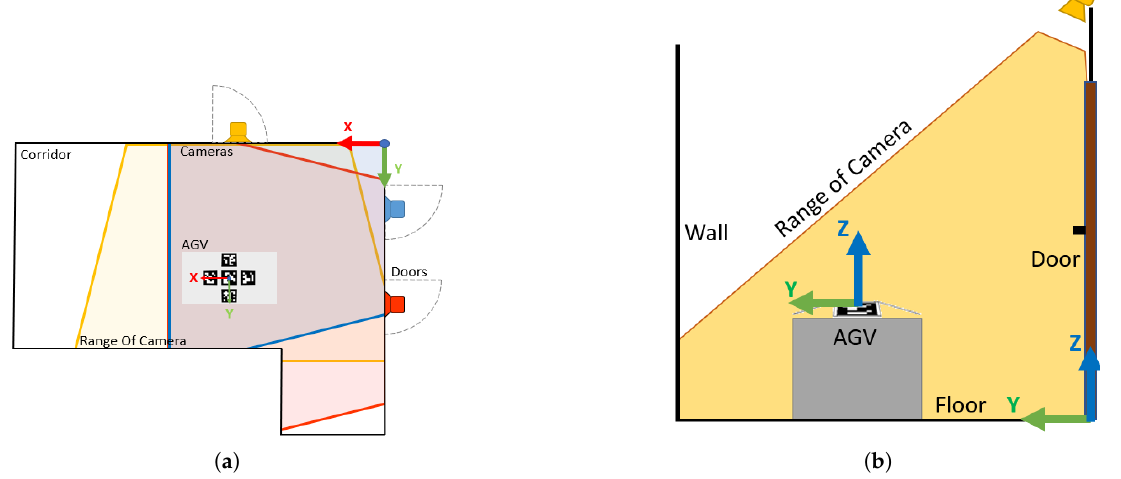
Figure 3. Schematics of cameras placement: ( a ) top view; ( b ) side view.